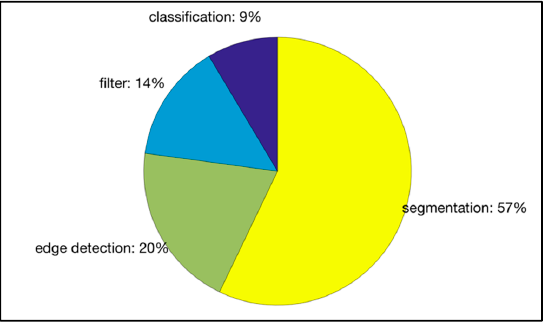
Figure 3. Pie chart showing the distribution of existing publications in the areas of focus for this paper.